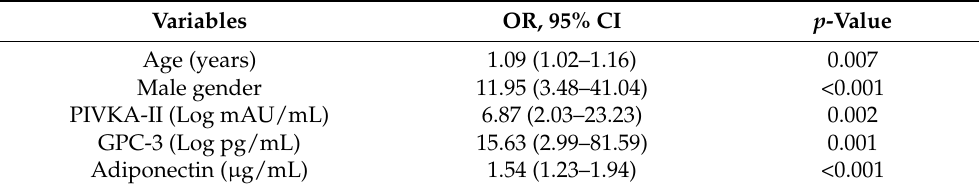
Table 4. Multivariate analysis for the factors associated to HCC.